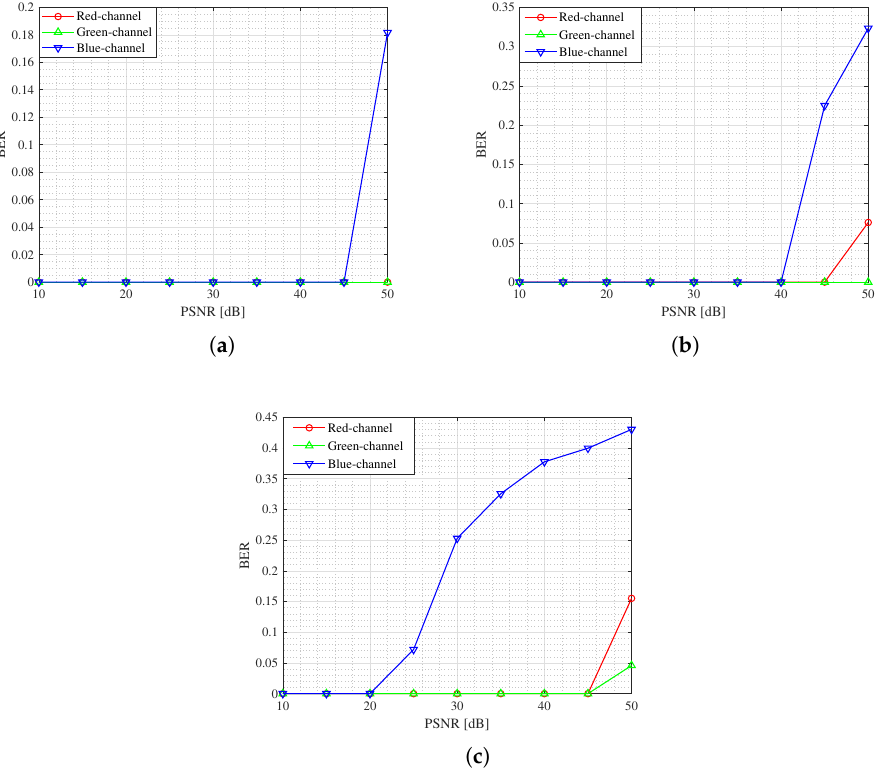
Figure 8. BER performance according to PSNR and transmit image size. ( a ) 128 × 128 pixel size. ( b ) 256 × 256 pixel size. ( c ) 512 × 512 pixel